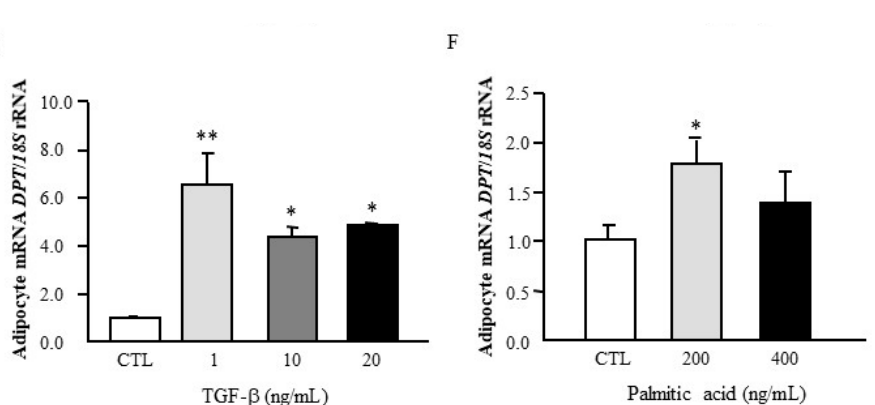
Figure 2. E ff ect of inflammation-related factors on mRNA levels of DPT . Gene expression levels of DPT in cultured human visceral adipocytes incubated during 24 h with ( A ) LPS, ( B ) TNF- α , ( C ) IL-4, ( D ) IL-13, ( E ) TGF- β and ( F ) palmitic acid. Gene expression levels in unstimulated cells were assumed to be 1. Values are the mean ± SEM ( n = 6 per group). Di ff erences between groups were analysed by